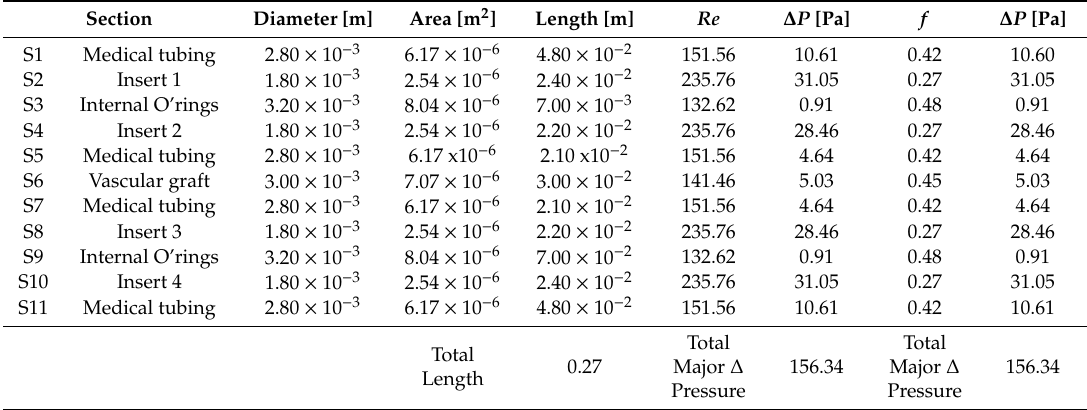
Table 4. Minor pressure losses along the fluidic system as calculated with the macroscopic